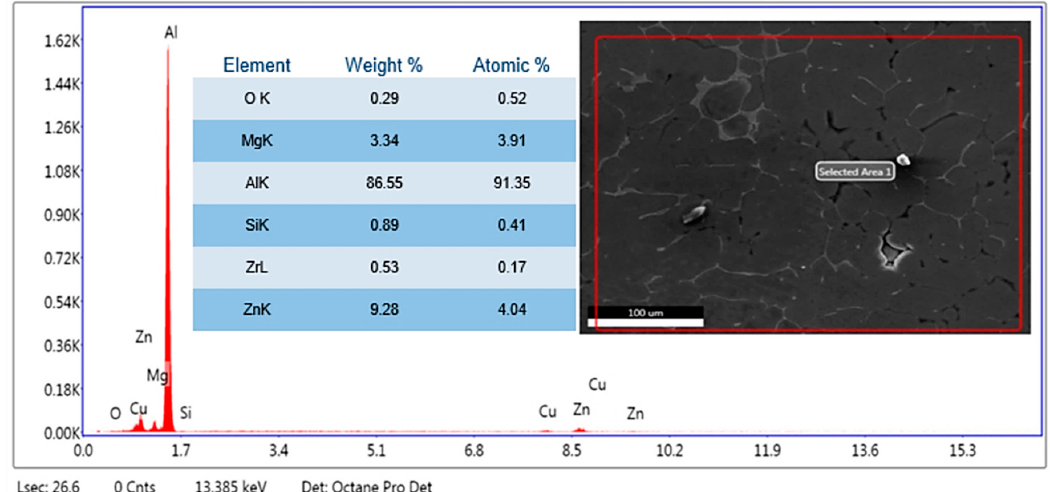
Figure 6. EDS of AA 5083/5 wt.% SiC/2 wt.% fly ash.